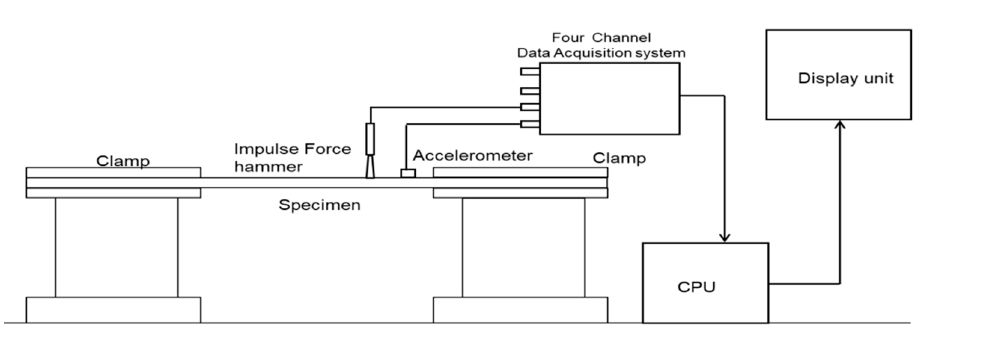
Figure 4. Experimental setup.